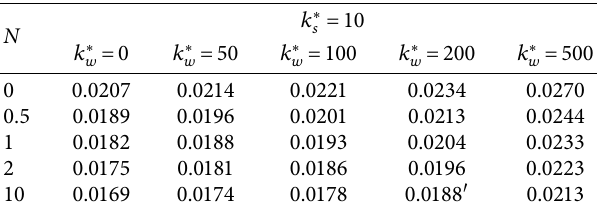
Table 8: First nondimensional natural frequencies ϖ of ZrO SUS304 plates depending on k ∗ s ( T �